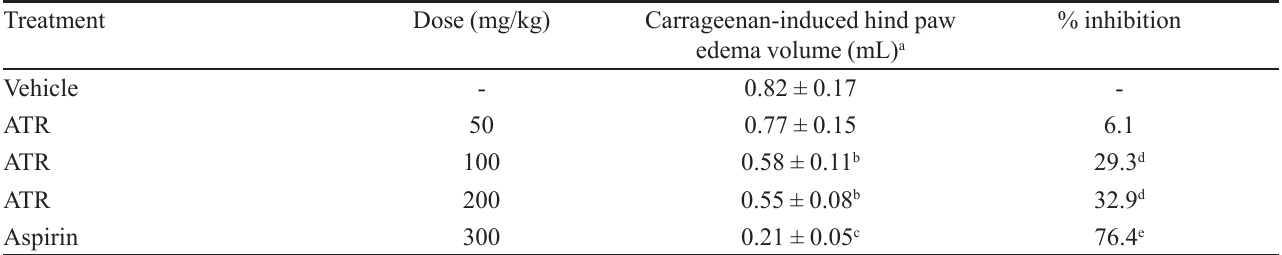
TABLE I - Effect of atranorin (ATR) or aspirin on carrageenan-induced hind paw edema in rats (n = 8)